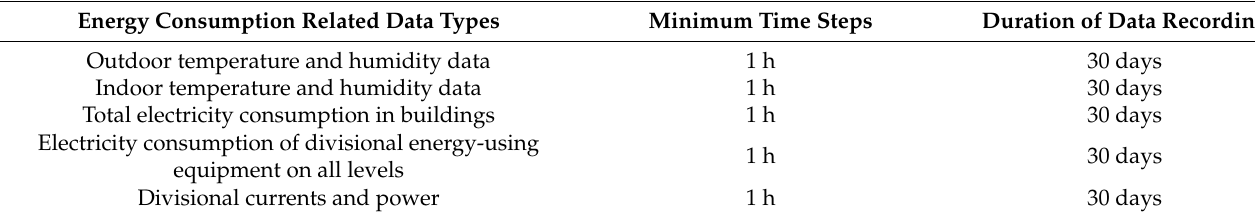
Table 3. Available energy data from monitoring